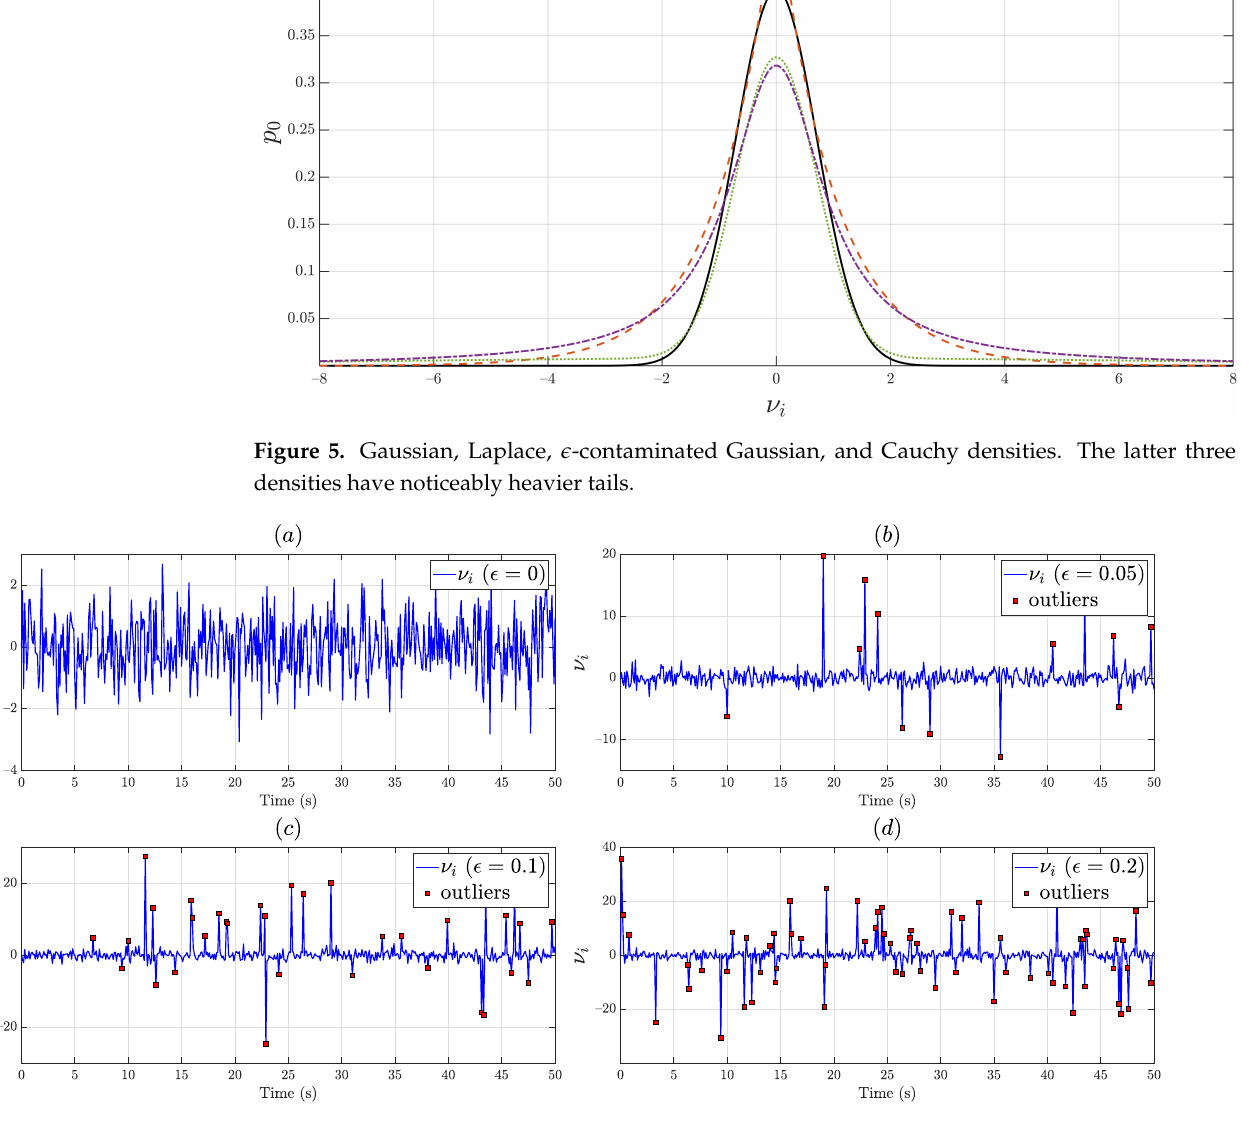
Figure 6. Effect of additive outliers on Gaussian noise: ( a ) (cid:101) = 0, no outlier contamination; ( b ) (cid:101) = 0.05, 5% outlier contamination; ( c ) (cid:101) = 0.10, 10% outlier contamination; ( d ) (cid:101) = 0.20, 20% outlier